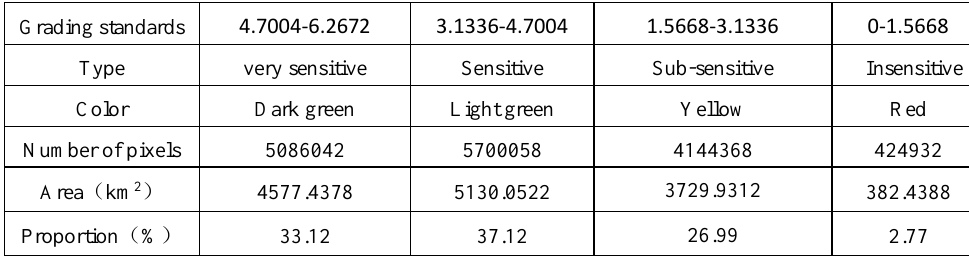
Table 5 Chaohu Lake basin sensitivity grading area and the proportion of all levels.